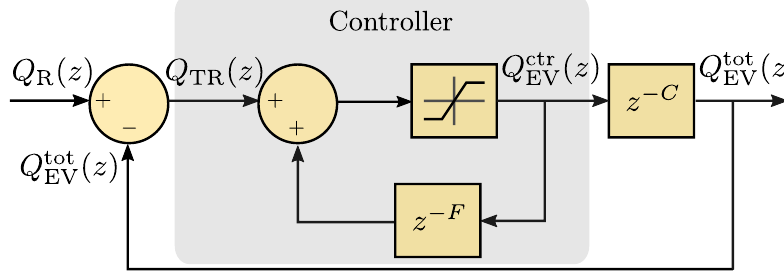
Figure 6. Simplified system and controller model for stability